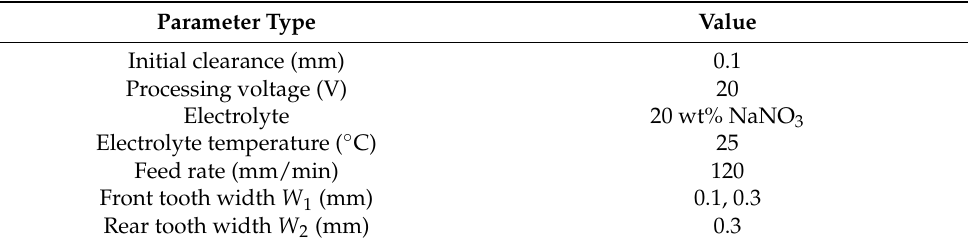
Table 2. Simulation parameters.